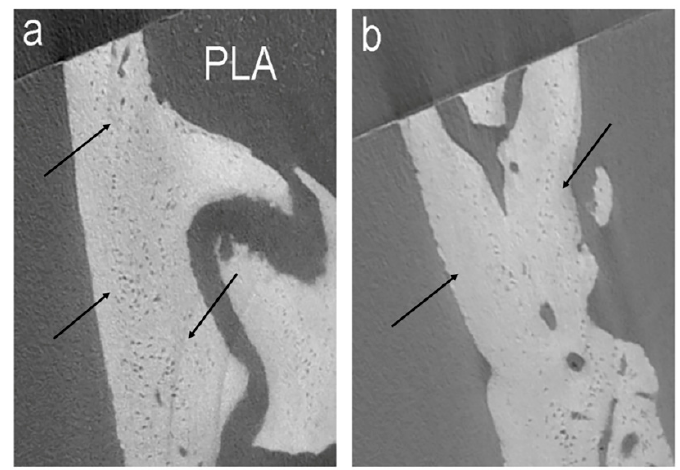
Figure 3. Evidence of bone remodeling kinetics. Representative microCT transversal sections of a PLA / hGMSCs / PEI-EVs sample in ( a ) test and ( b ) ctr sites. As shown by the arrows, in the test sites and close to the PLA residuals, bone appeared to be much denser of osteocyte lacunae than in the corresponding ctr sites, showing increased remodeling.